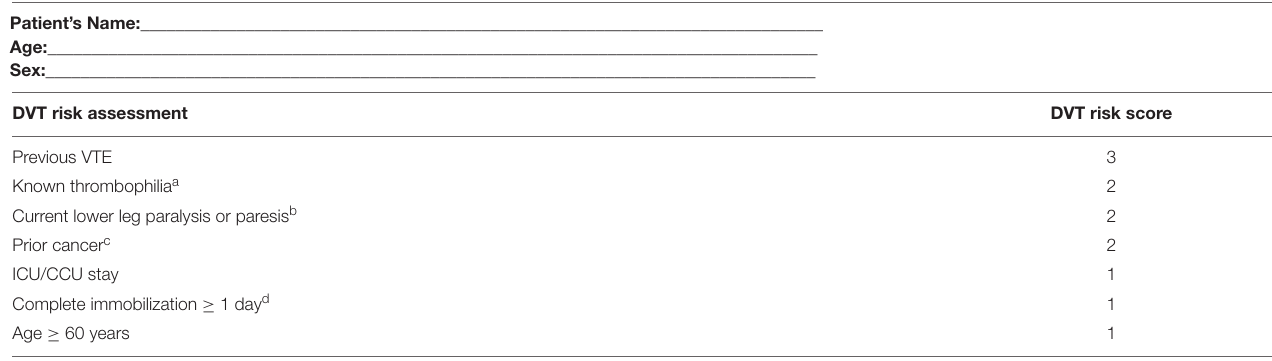
TABLE 3 | Modified IMPROVE risk